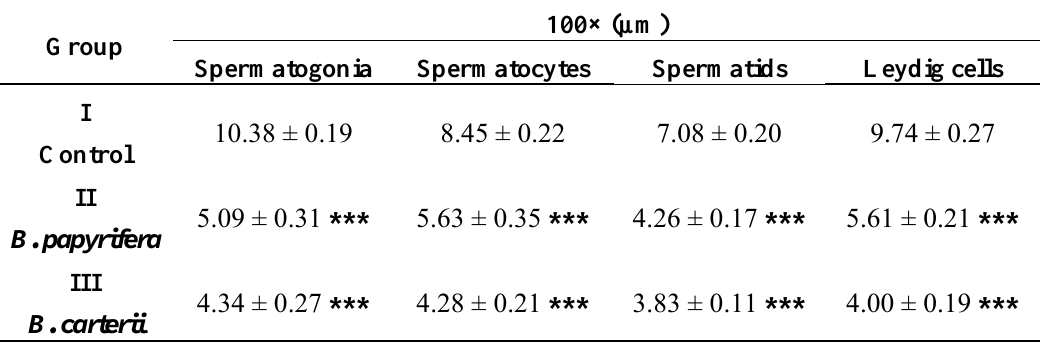
Table 4. Effect B. carterii and B. papyrifera smoke exposure on nuclear diameter (µm) of the germ cells in testis of albino